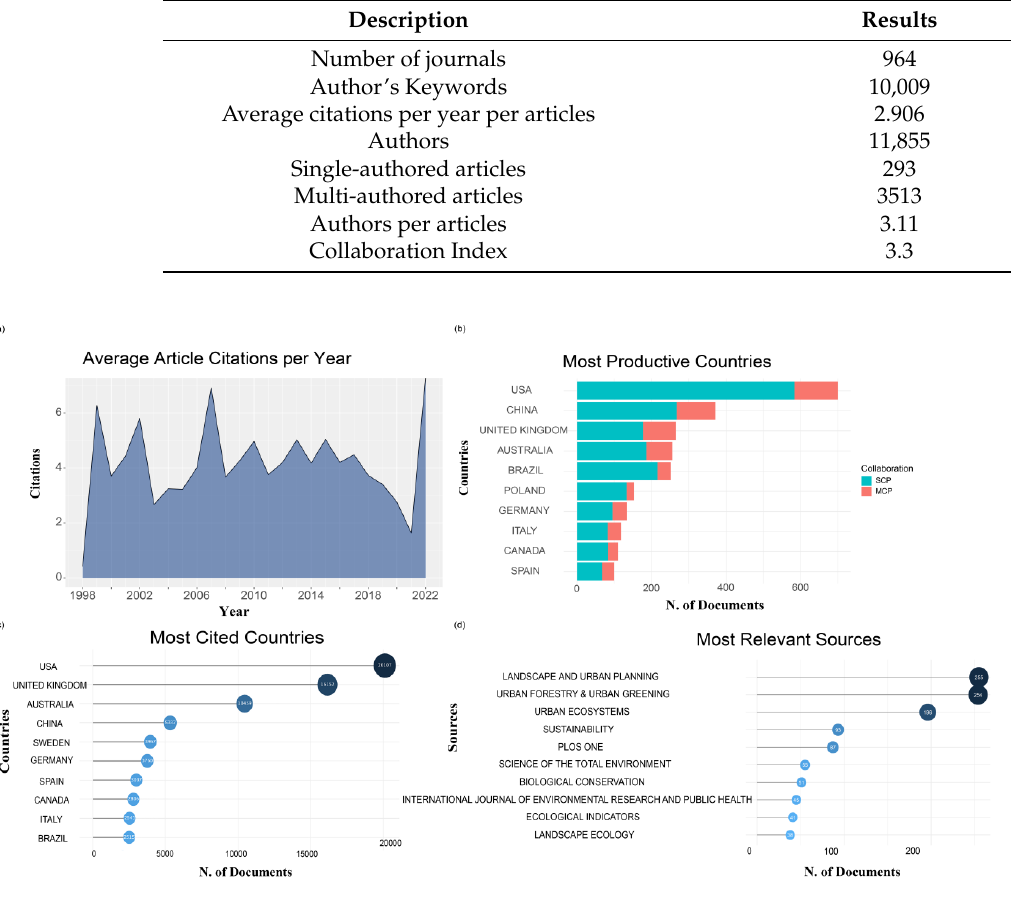
Figure 2. Basic features of all the articles. ( a ) The average number of citations per year from 1998 to 2021. ( b ) Top ten countries in terms of the number of publications, in which SCP stands for single country publications and MCP stands for multiple country publications. ( c ) Top ten countries with in terms of the number of cited articles. ( d ) Top ten journals in terms of the number of publications.